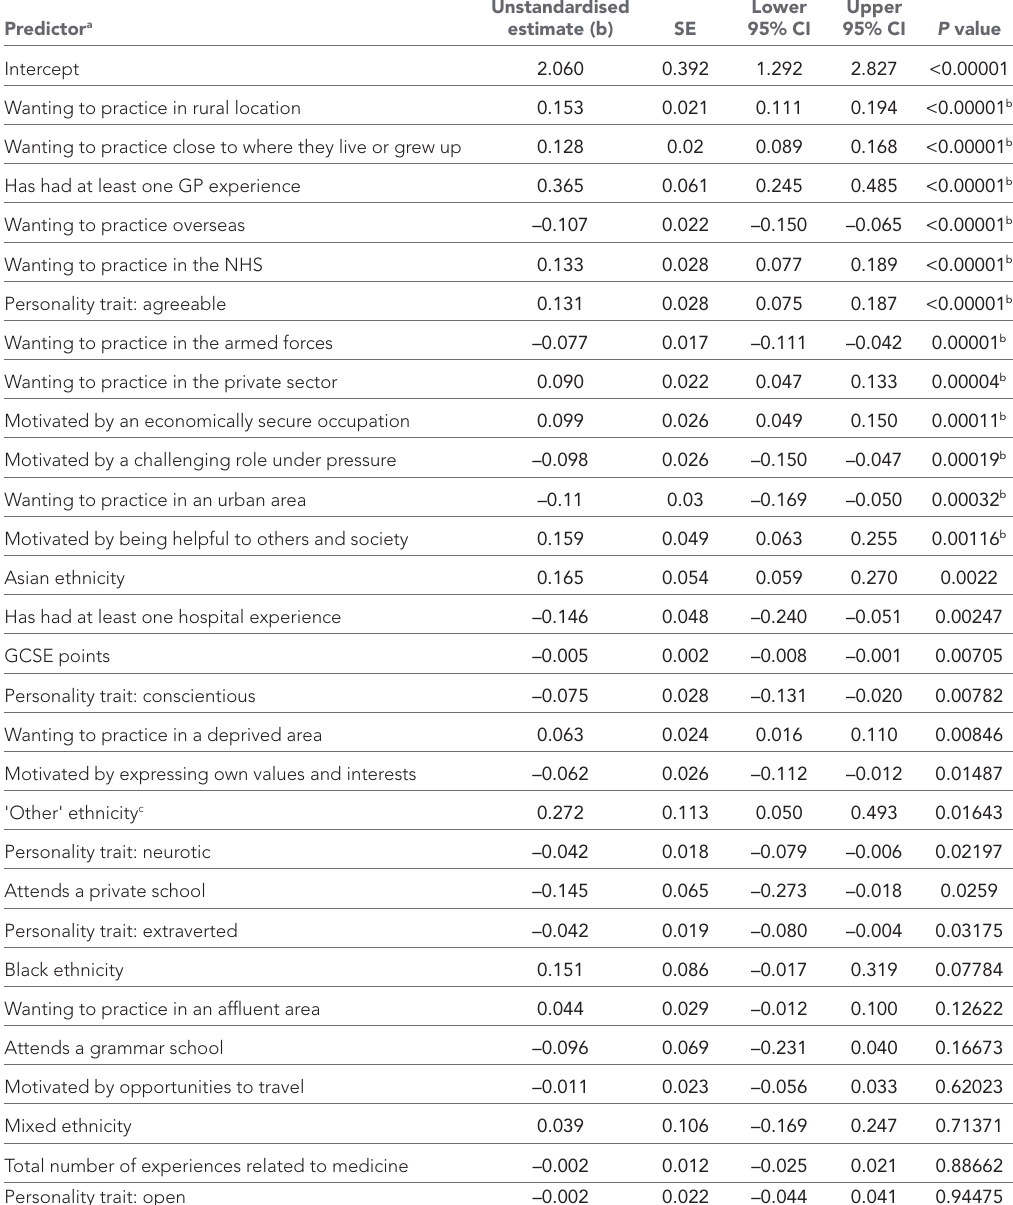
Table 1 Predictors of finding general practice appealing as a future career (pooled results from 10 multiple imputations). Predictors ordered by significance level Predictor a